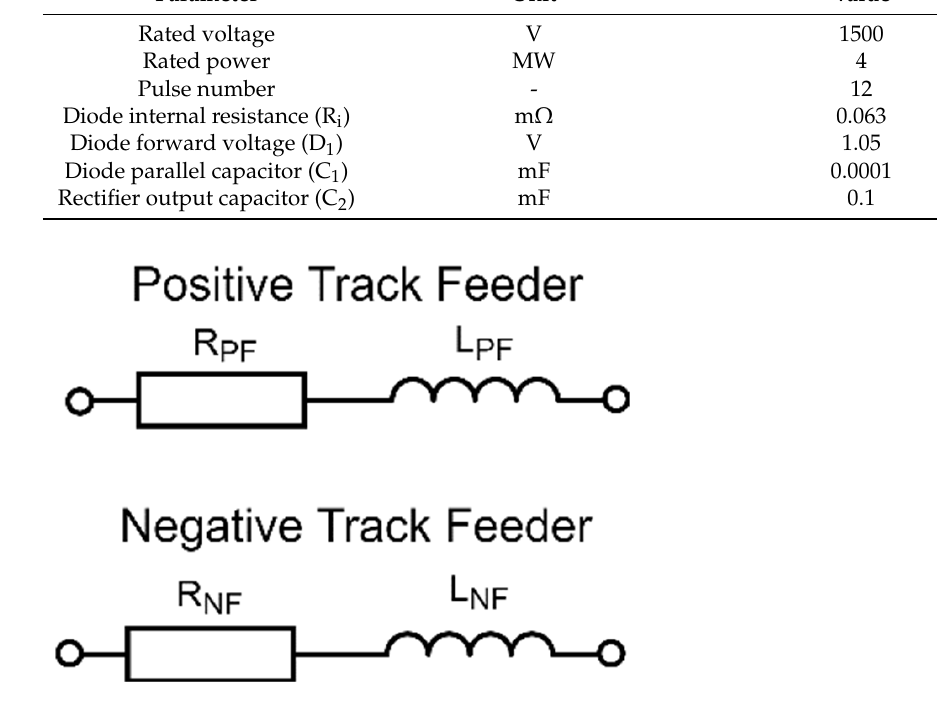
Figure 5. Substation positive and negative feeders modeled in MATLAB/Simulink.